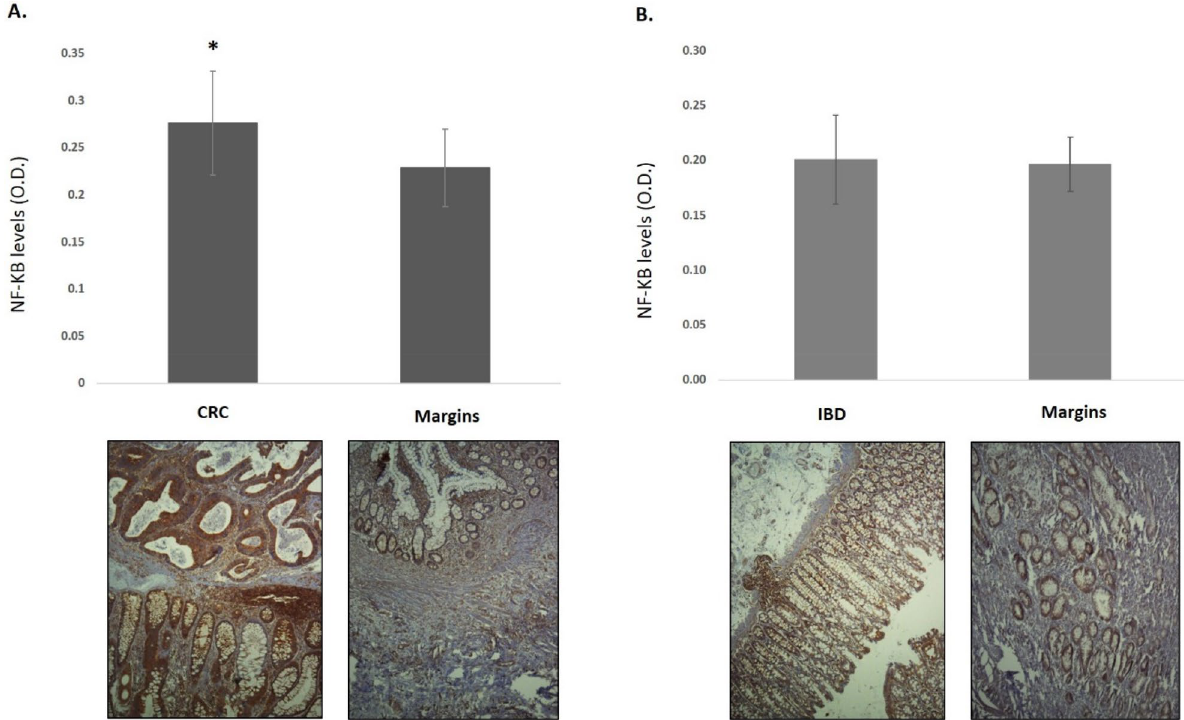
Figure 4. Histological images Cancer and Crohn’s disease—immunohistochemistry staining of NF-κB is seen in brown.